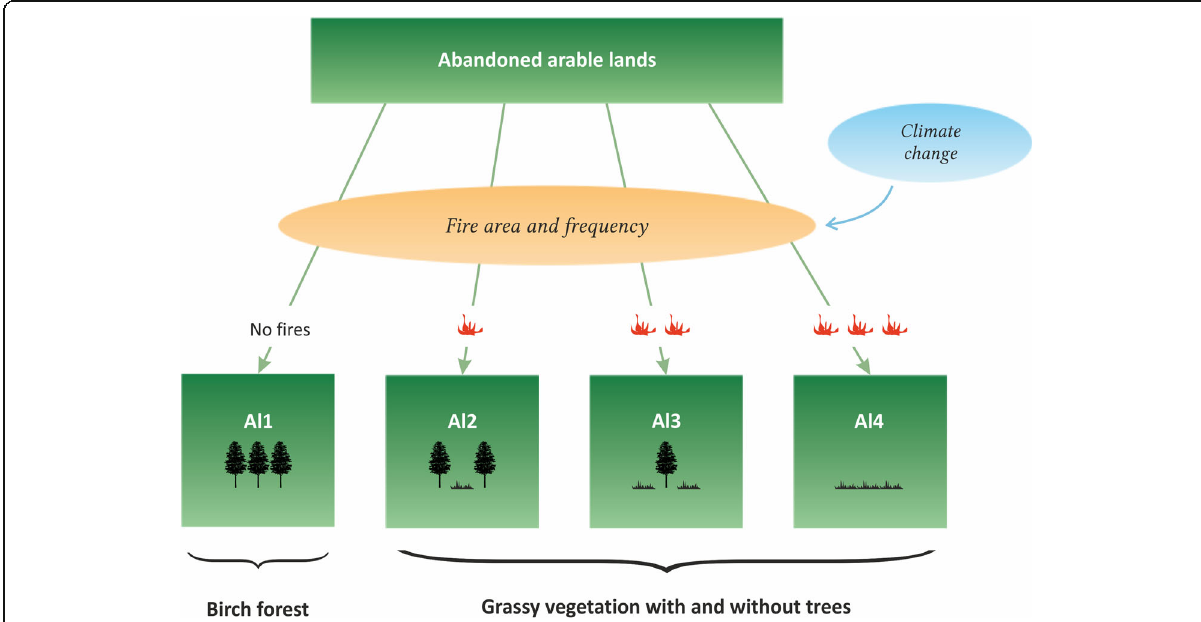
Fig. 12 Effects of spring grass fires on successional trajectories of vegetation in abandoned arable lands in Central Russian